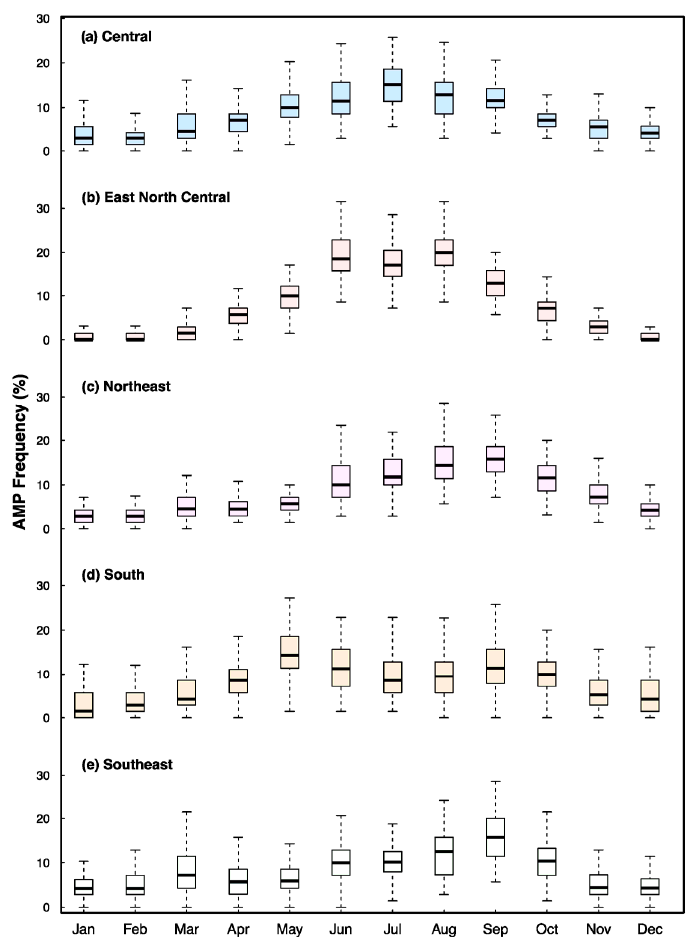
Figure 2. The percentage of station monthly count of annual maximum precipitation (AMP) timing over 70 years (1950–2019).